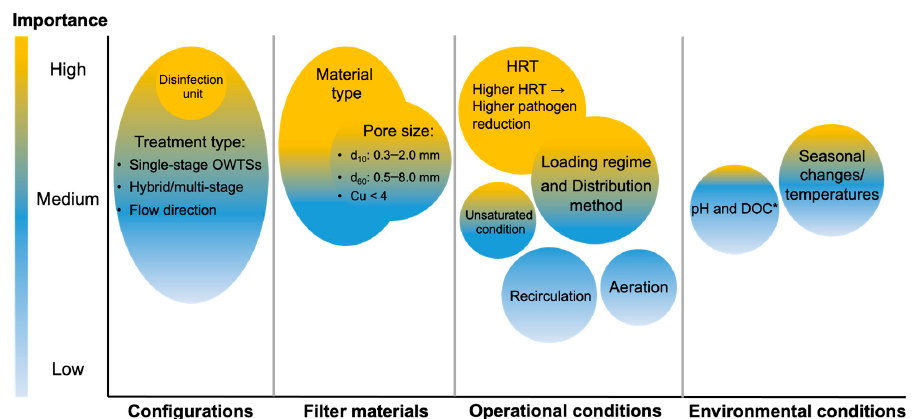
Figure 2. A bubble graph illustrating the significance of each contributing factor to the pathogen removal rates. Different factors are categorized into four aspects. The colors represent the importance of these factors in previous studies. A larger portion of the yellow region indicates that the factor is significant for high removal rates reported by a large number of studies, while the light blue color region represents that its effect is negligible in some studies. The size stands for the design space of the contributing factor. *Pathogen reductions based on the filter material and pathogen types.